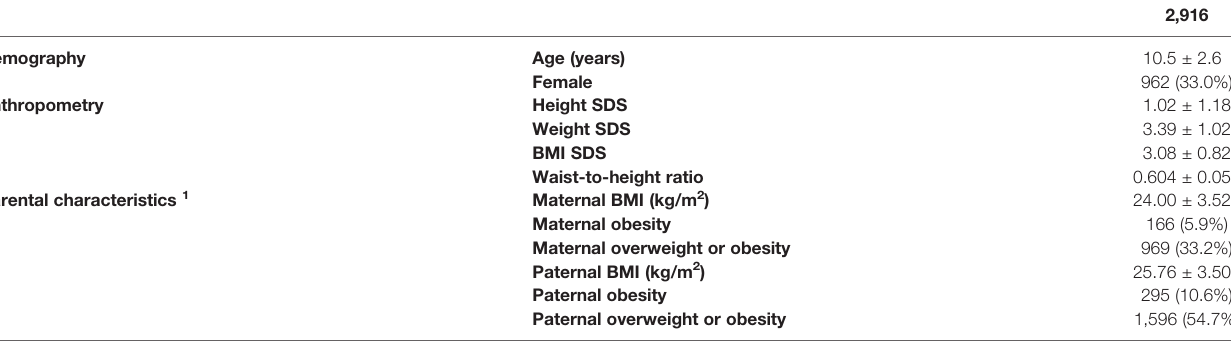
TABLE 2 | Demographic, anthropometric, and clinical characteristics of our study population of children and adolescents with obesity from Hangzhou (Zhejiang Province, China) in 2008 – 2017.